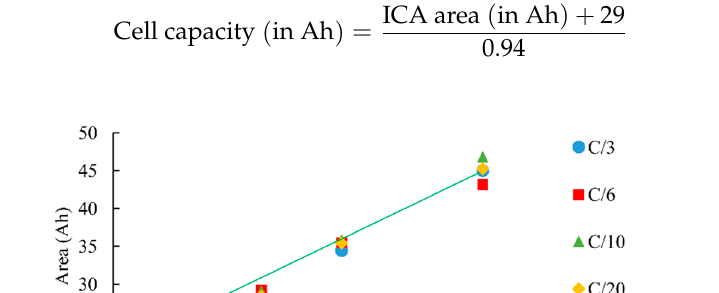
Figure 10. Measured area function of cell capacity for various charging currents and with pause before peak 2 (100% DoD-25 °C).